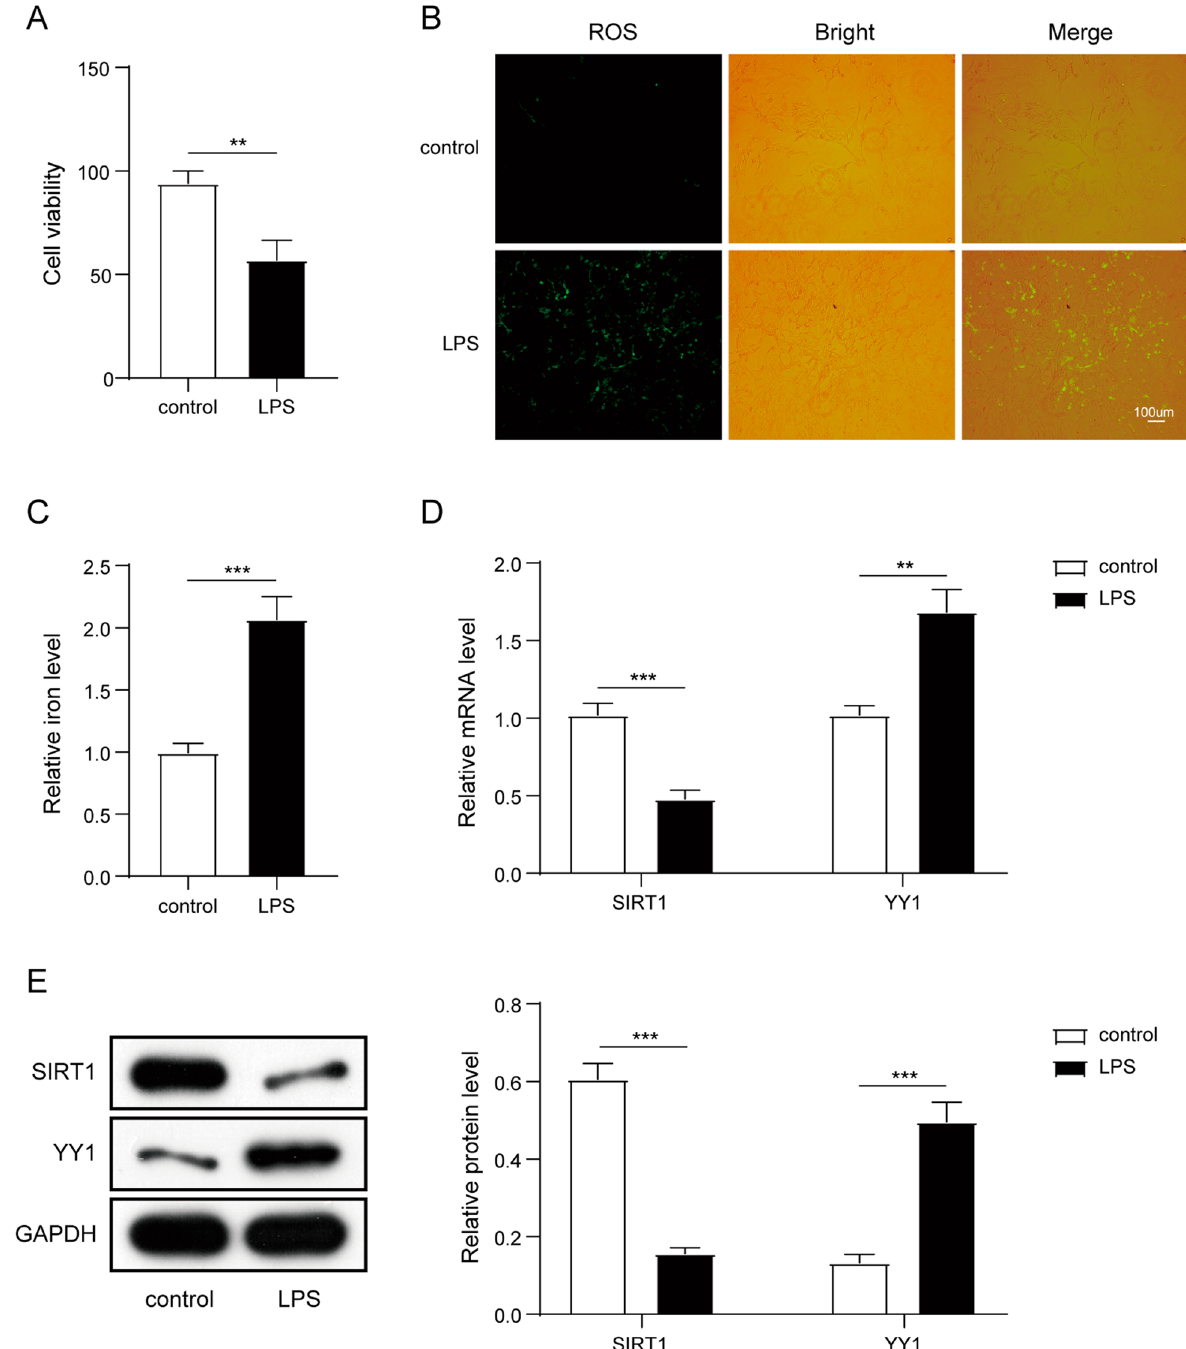
Fig. 2 SIRT1 was downregulated while ferroptosis and YY1 was upregulated in LPS-induced synoviocytes. A CCK-8 assay assessed viability. B ROS production was detected by DCFH-DA fluorescent probe. C Iron level in the synoviocytes was examined by iron assay kit. D The mRNA expressions of YY1 and SIRT1 in the synoviocytes were examined by qPCR. E The protein levels of YY1 and SIRT1 were detected by western blot. Experiments were carried out in triplicate, mean SD, **p < 0.01; * **p < ±